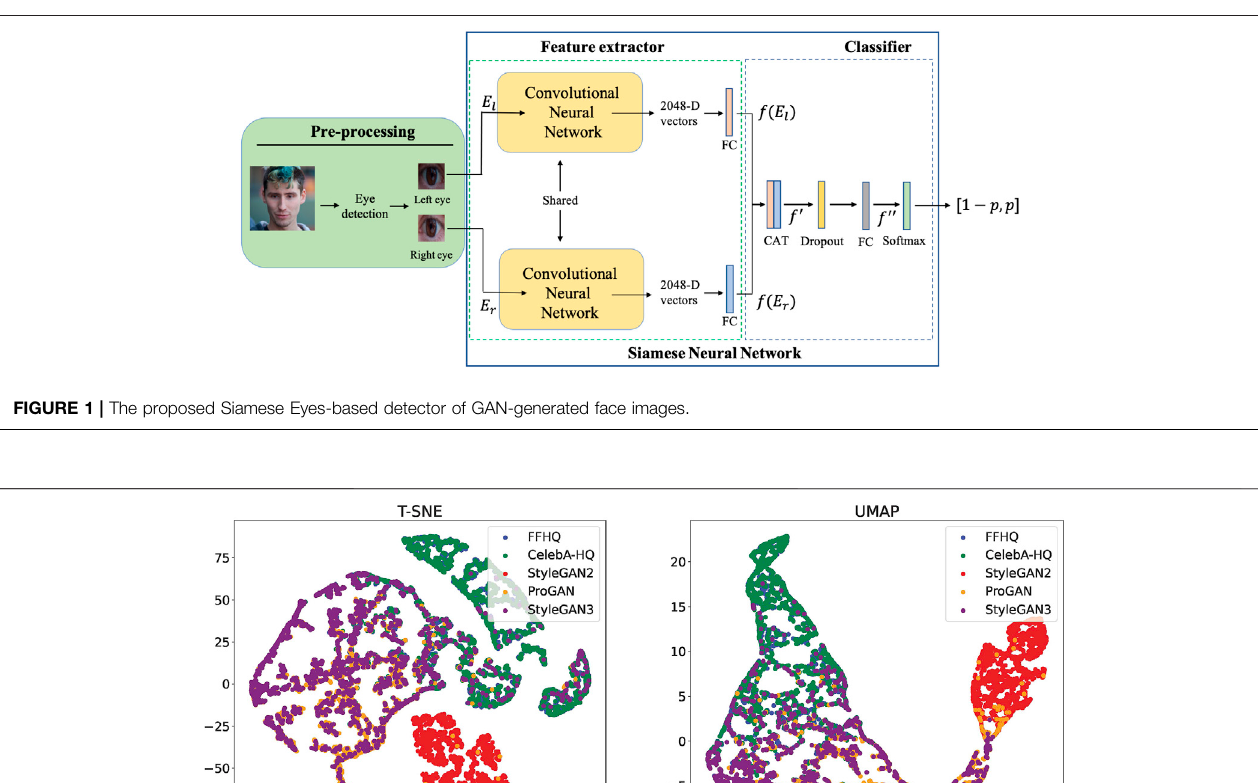
Frontiers in Signal Processing |